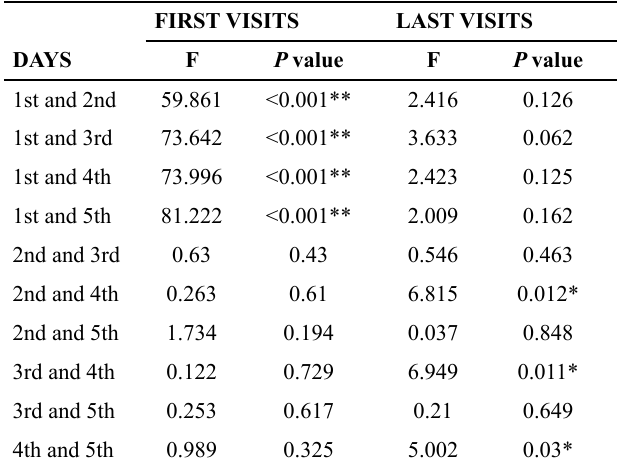
Table 1 Results of Watson-Williams F tests performed to show the differences between days and times of the first visits and the last inspections of Melipona subnitida foragers to a source of artificial